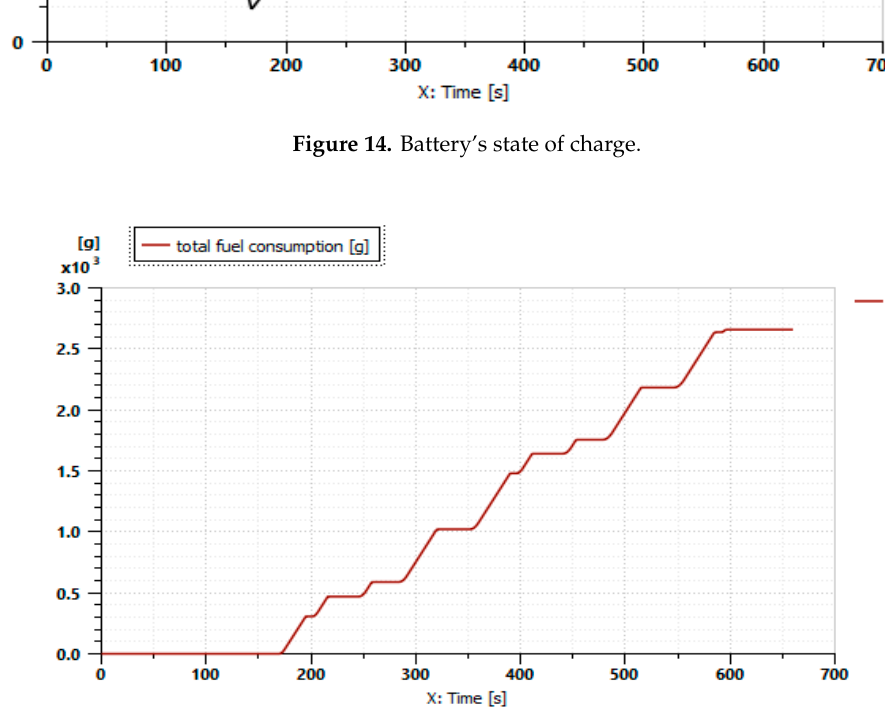
Figure 15. Fuel consumption.